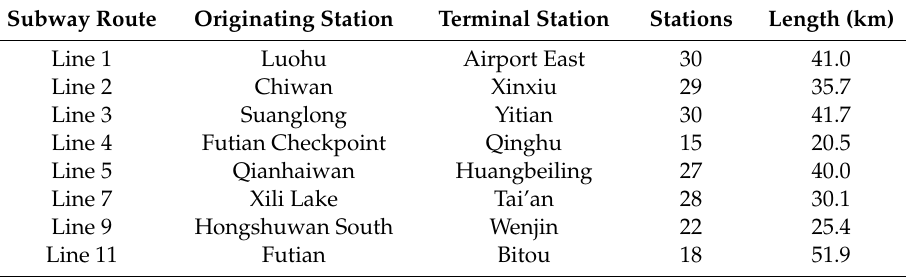
Figure 5. Diagram showing the structure of the subway network of Shenzhen. Table 2. Information on the subway lines of